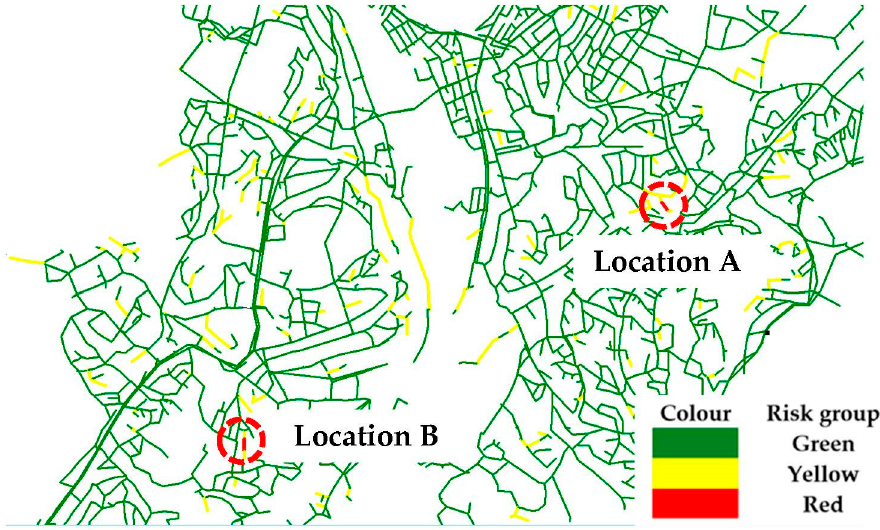
Figure 7. Locations of critical pipes from risk assessment for all service scenarios tested.